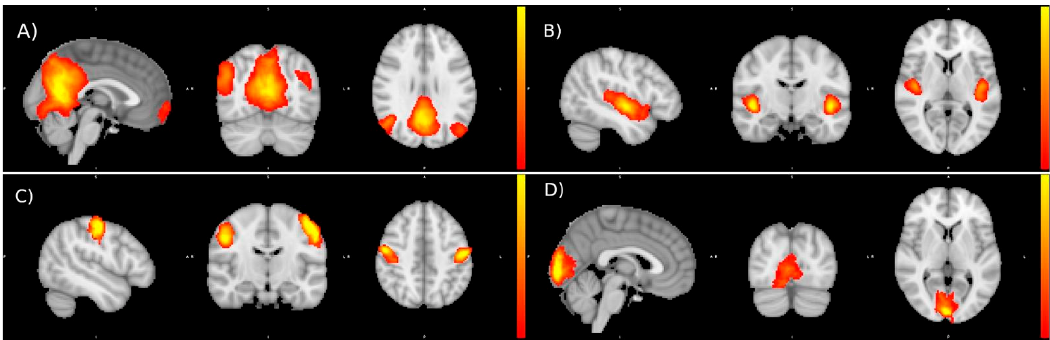
Figure 2. Examples of resting state networks identified by ICA: default mode network ( A ), auditory network ( B ), sensory-motor network ( C ), and visual network ( D ).